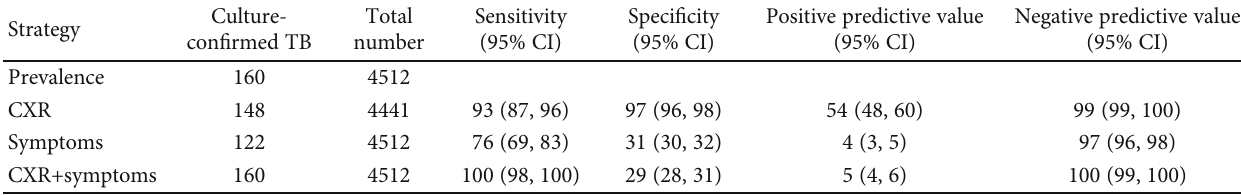
Table 2: Performance of the CXR or symptoms in screening culture-con fi rmed pulmonary tuberculosis.